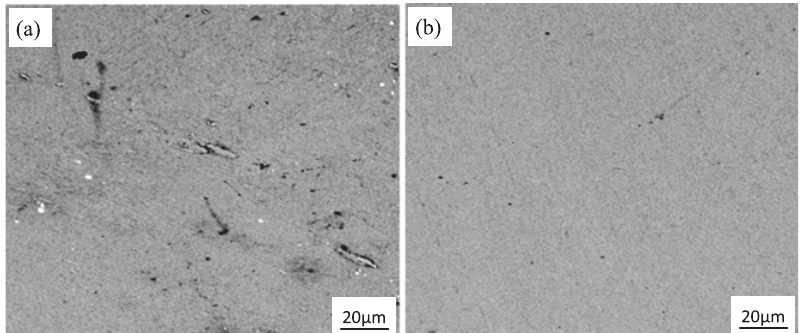
Fig. 2: SEM-BSE images of the CuZn alloy. (a) Original; (b) after 3 GPa treatment